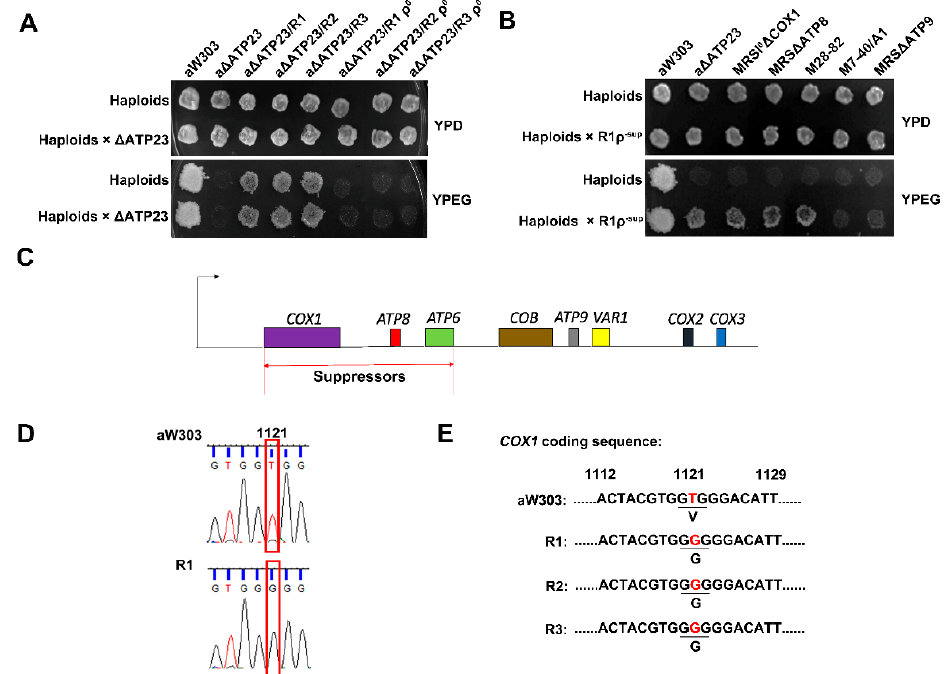
Figure 2. Locating the suppressor(s) in revertants. ( A ) Growth of diploids that revertants (R1, R2, R3) or ρ 0 of the revertants (R1 ρ 0 , R2 ρ 0 , R3 ρ 0 ) crossed to atp23 null mutant on YPD or YPEG medium. ρ 0 colonies with complete deletion of mitochondrial DNA were obtained from revertants treated with ethidium bromide. ( B ) Growth of ρ − sup colonies crossed to atp23 null mutant and mitochondrial DNA mutant testers on YPD and YPEG medium. ρ − sup represents ρ − colony with partial mi- tochondrial DNA fragment containing the suppressor. M28-82 and M7-40/A1 are atp6 and cob loss-of-function mutants, respectively ( C ) Diagram of localization of the suppressor(s) in mito- chondrial DNA region of revertant R1. ( D ) Sequencing result of COX1 coding sequence within mitochondrial DNA fragment in ρ − sup colony derived from revertant R1. ( E ) Sequencing results of COX1 coding sequence in mitochondrial genome of three revertants.